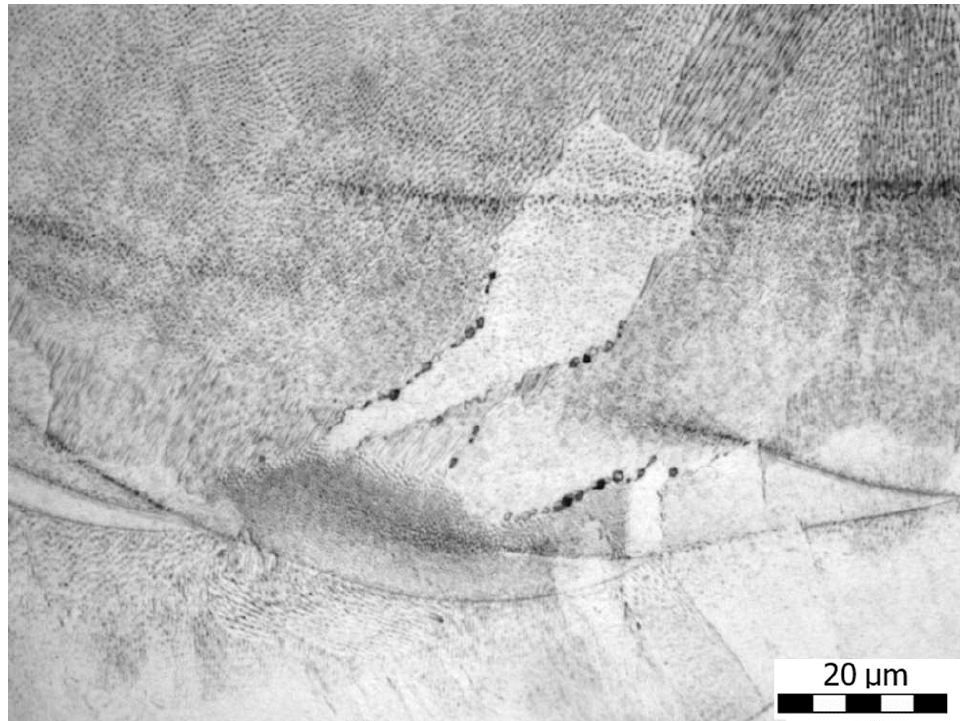
Figure 8. Microstructure of 3D samples: ( a ) surface A; ( b ) perpendicular B; ( c ) parallel C to the printing base.